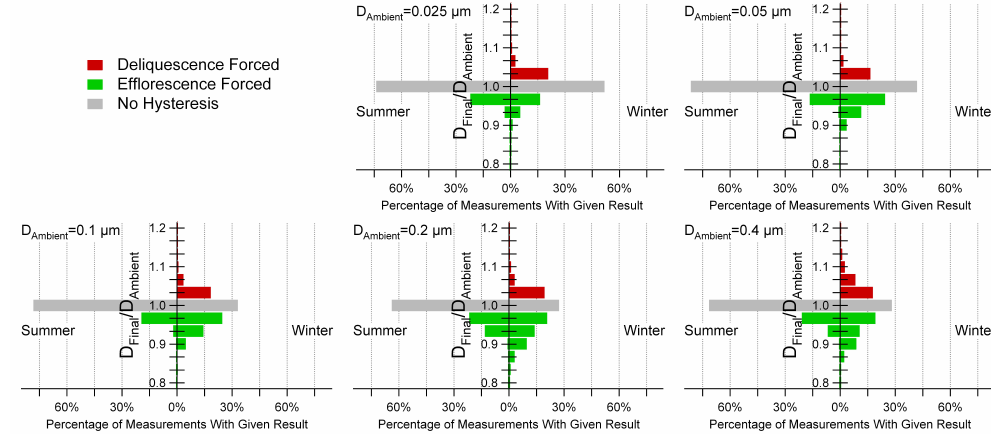
Fig. 10. Deliquescence and efflorescence forcing measurement summaries for the summer and winter campaigns.